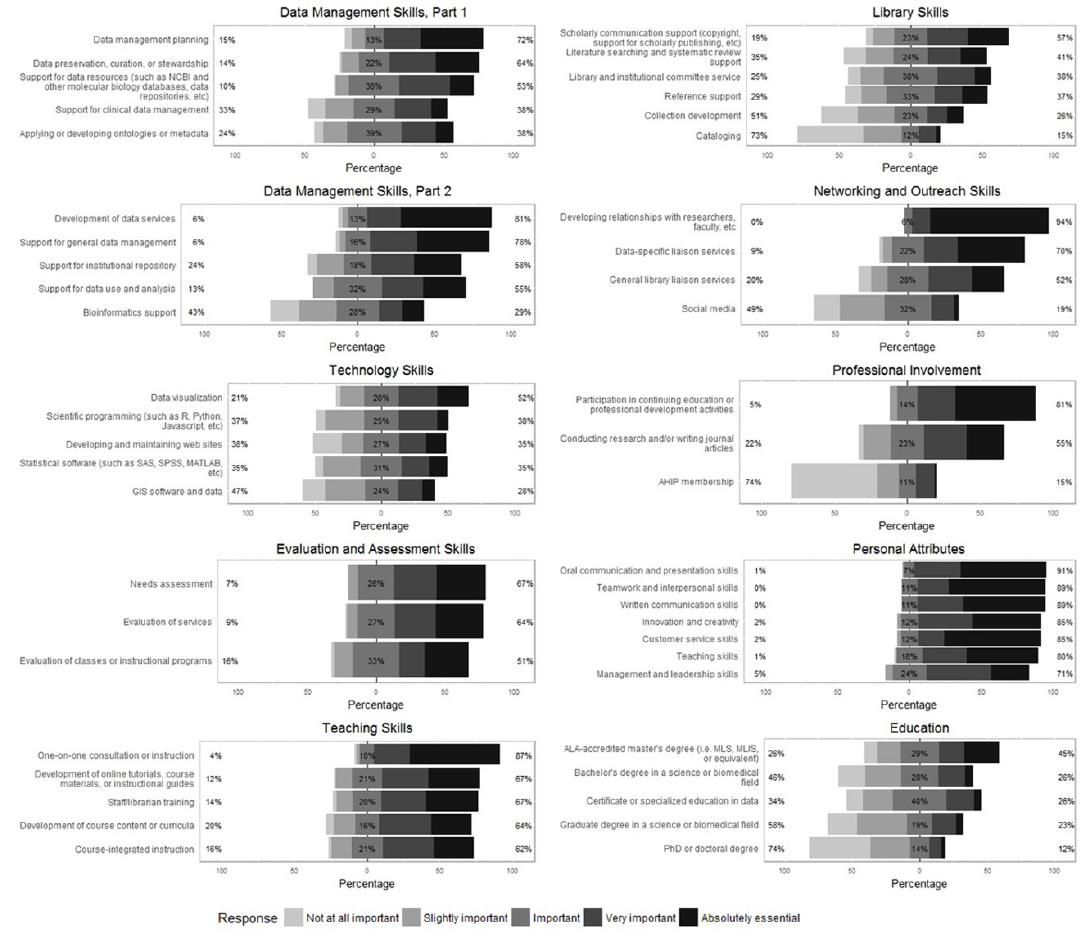
Figure 1 Overall ratings for each item, by category*